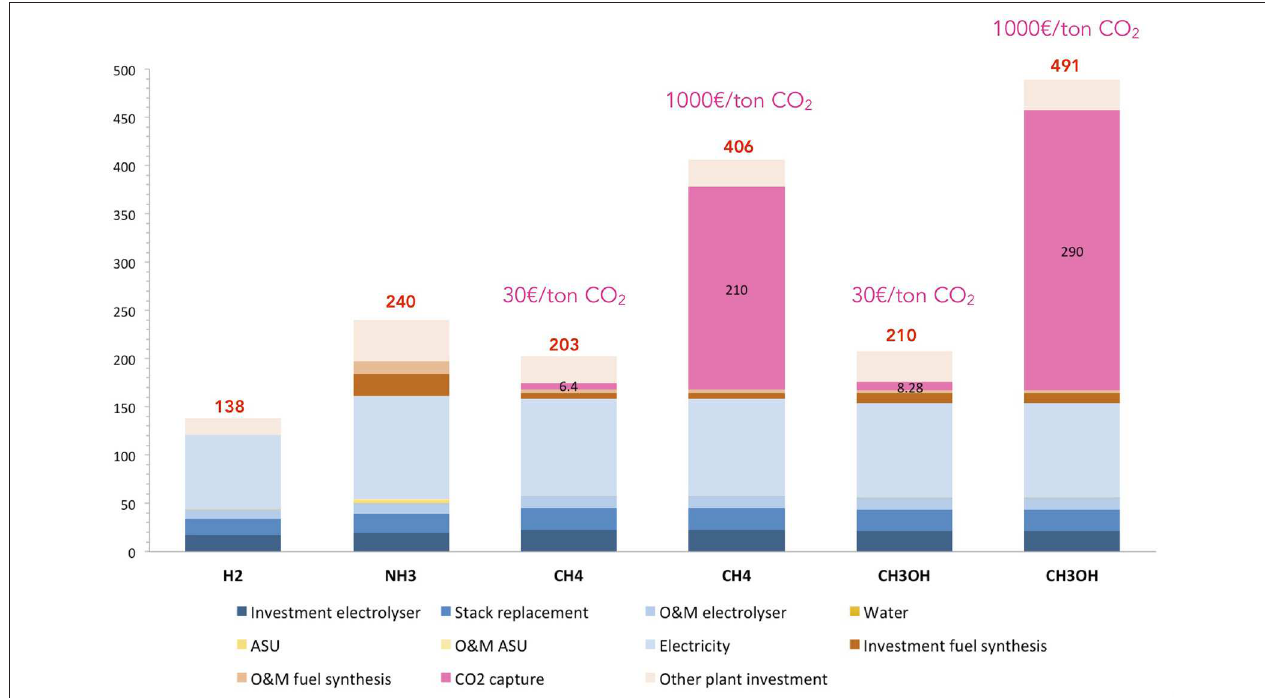
FIGURE 5 | Production costs for each fuel in e /MWh fuel , with 30 e /ton CO 2 and 1,000 e /ton CO 2 .